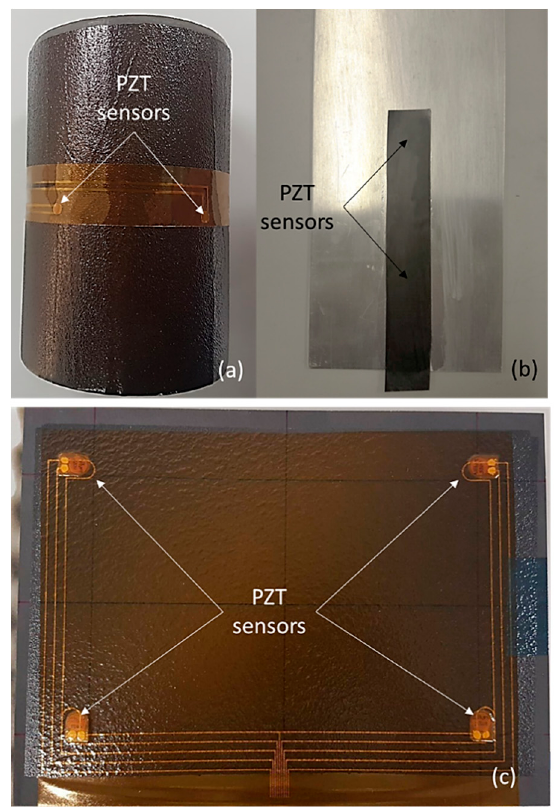
Figure 13. The developed thin film attached to ( a ) cylindrical CFRP, ( b ) aluminum, and ( c ) CFRP plate.